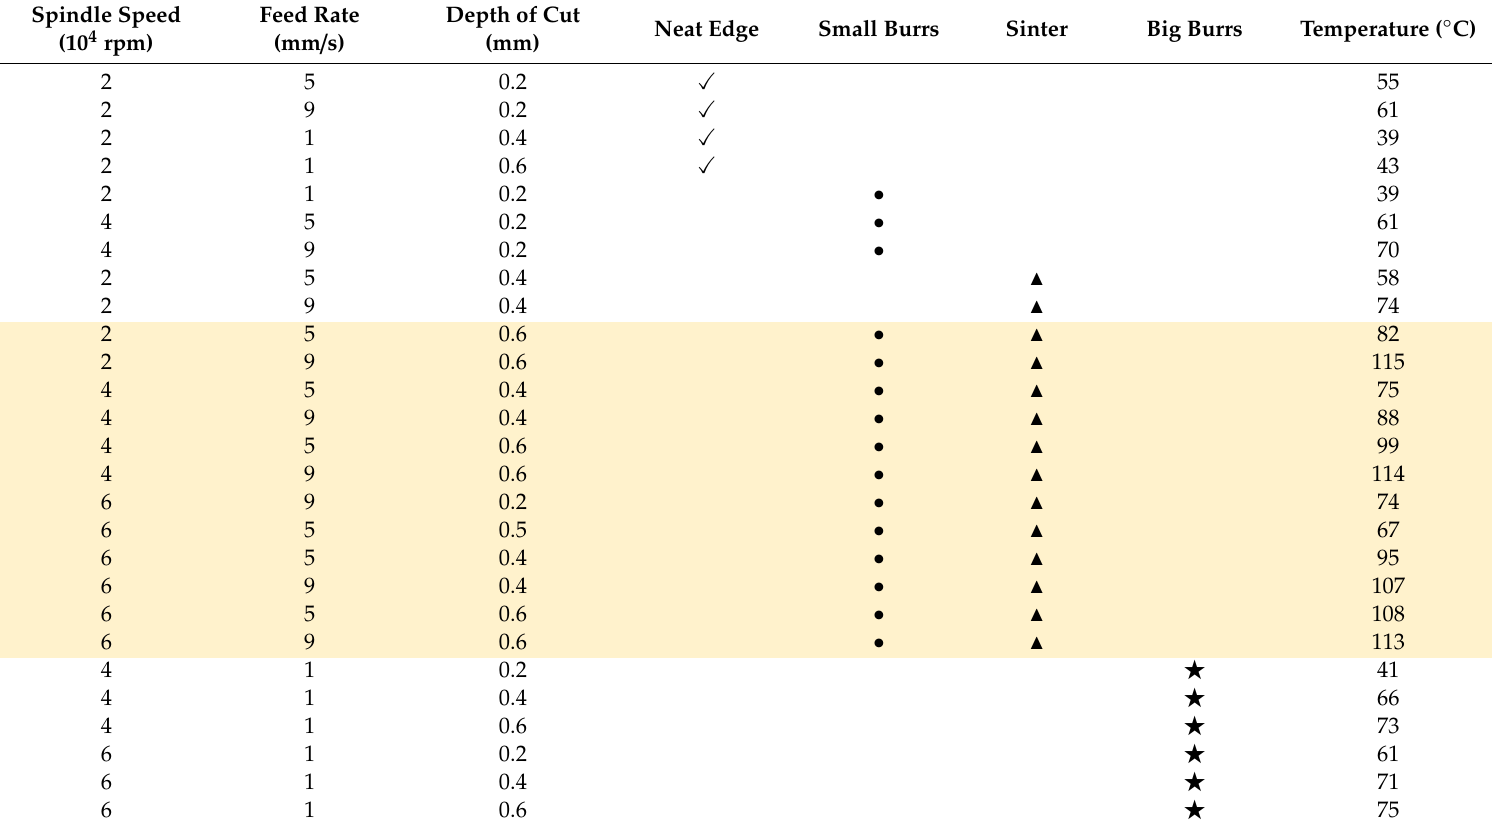
Table 2. Burrs’ characteristics under di ff erent micromilling